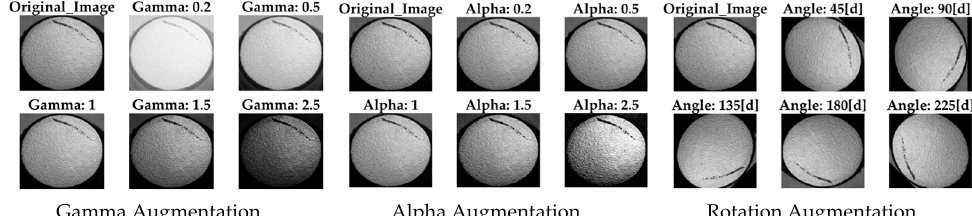
Figure 6. Examples for data augmentation. Thereby, the following augmentation and combinations of it were used to simulate scenarios AP (=augmented pixel) which are difficult to find while collecting real